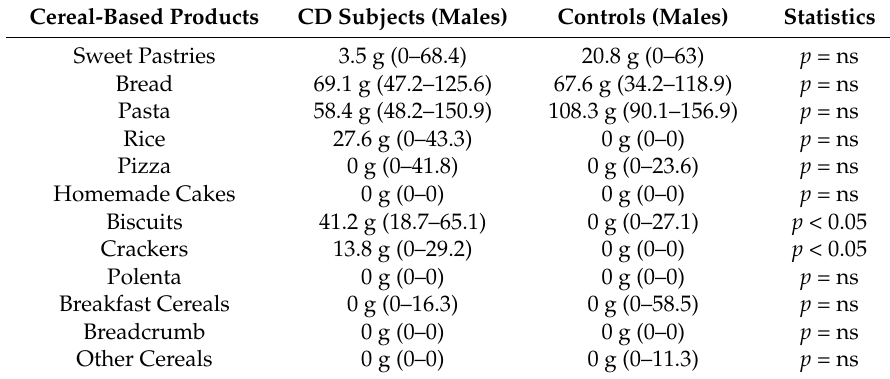
Table 3. Median and inter-quartile range daily consumption of cereal-based products in CD patients and controls (males). Comparison was made by Mann–Whitney test.